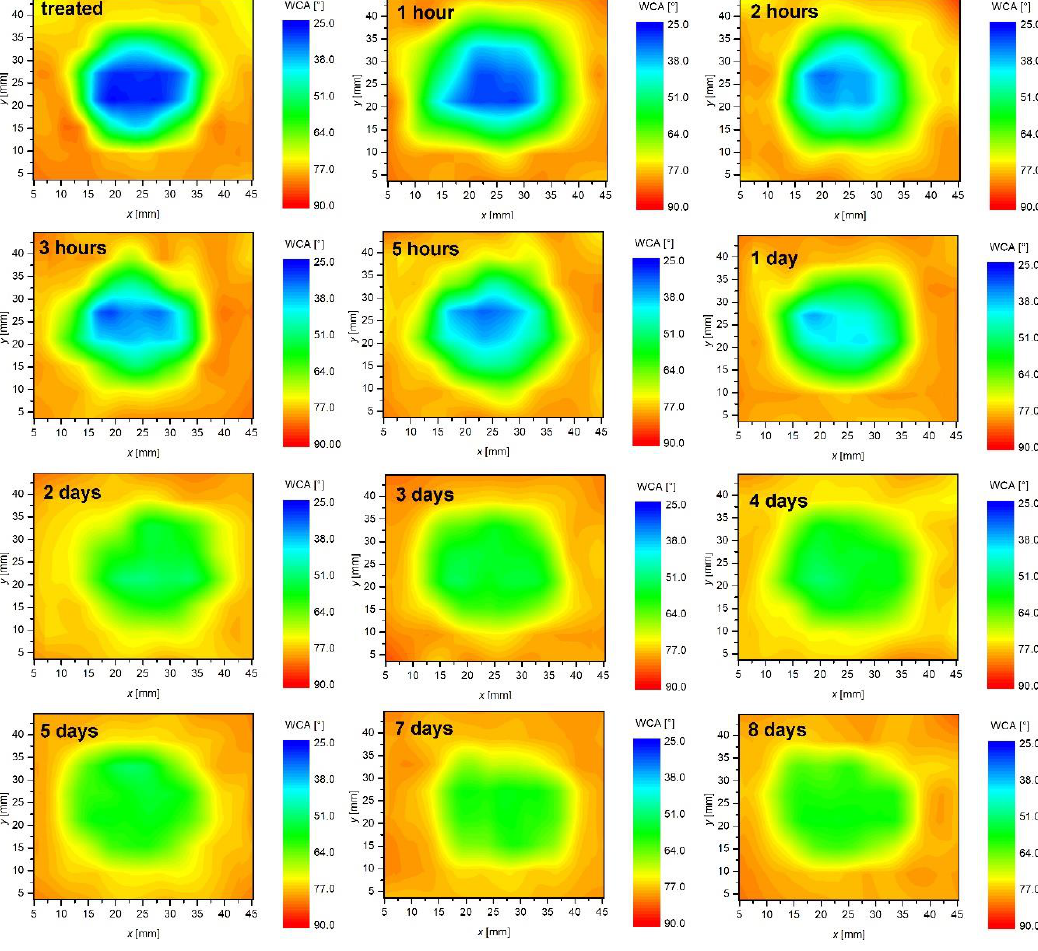
Figure 11. 2D evolution of water contact angles versus aging time.